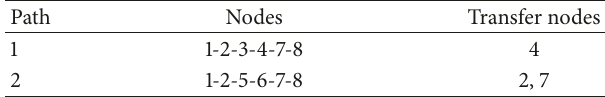
Table 3: Valid paths for given OD pair (Node1-Node 8). Path Nodes Transfer nodes